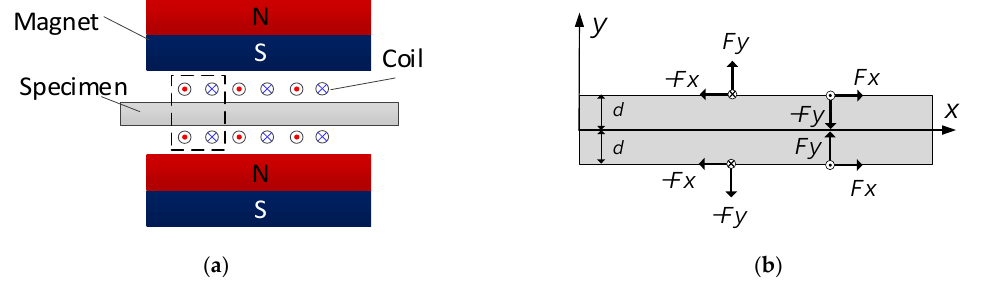
Figure 4. ( a ) The paired normal biased EMAT (NB-EMAT) configuration, and ( b ) the Lorentz forces generated by the paired NB-EMAT. Only the Lorentz forces generated by the wires in the dotted frame (cid:78) are plotted in (b). The symbol denotes the inward current flows on the paper vertically, and denotes the outward current flows on the paper